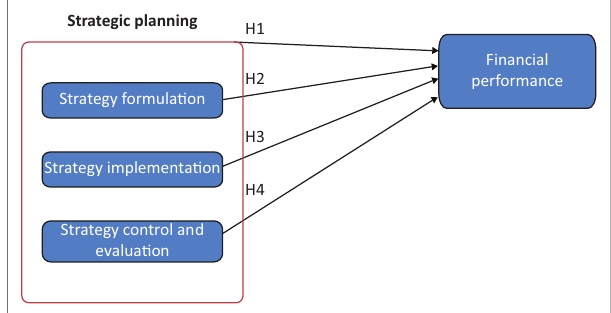
FIGURE 1: Conceptual framework: Hypothesised model of the relationship between strategic planning and financial